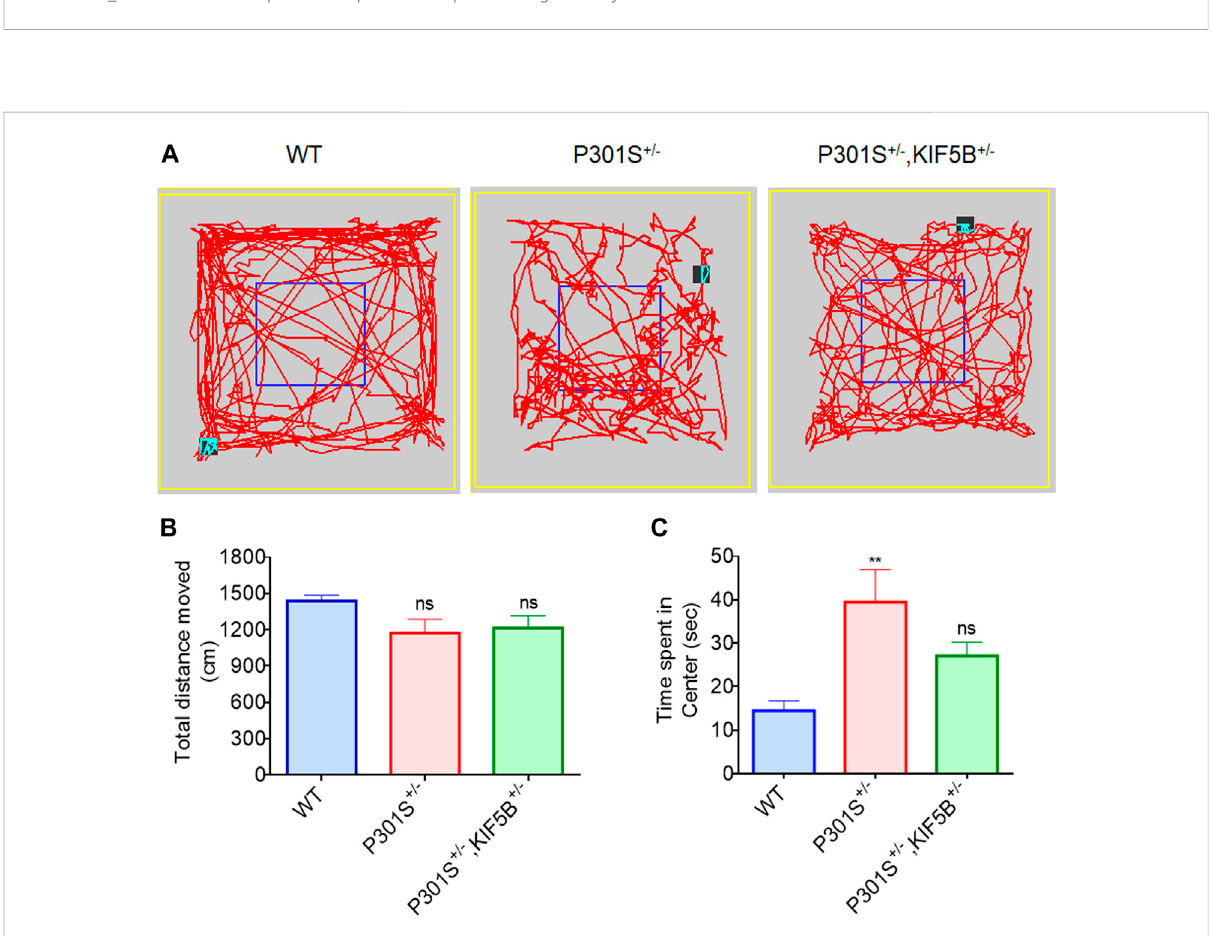
FIGURE 5 Open fi eld behavioural analysis. (A) Representative patterns of exploratory behaviour exhibited by mice in each group. (B) Total distance travelled in the open fi eld test. (C) Quanti fi cation of time spent in the center for each group. Date represent mean ± SEM and WT mice